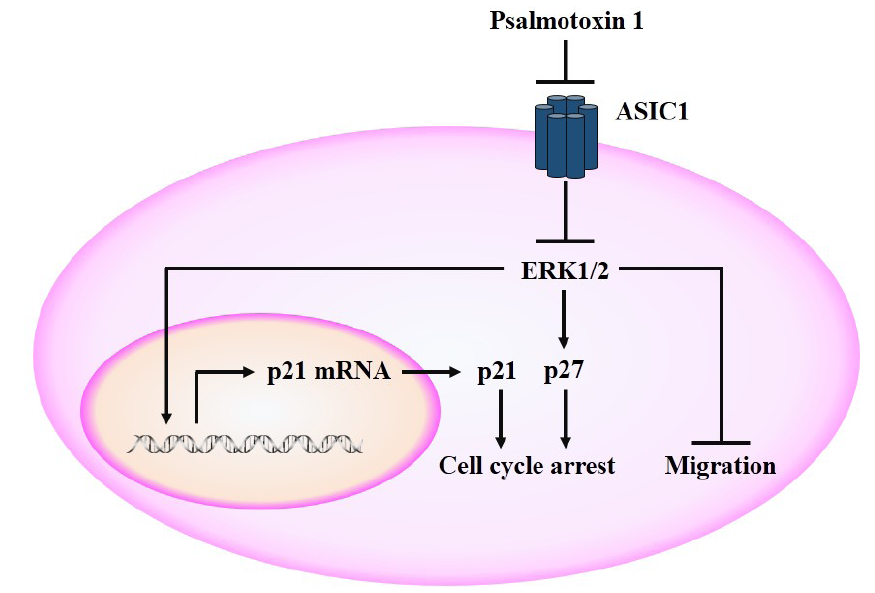
Figure 3. The anti-tumor mechanism of PcTx1. PcTx1 can suppress activation of ERK1/2 by inhibiting ASIC1 channels, followed by upregulating p21 and p27 protein expression to arrest the cell cycle. The level of p21 mRNA increases, but that of p27 mRNA does not change. The inhibition of ERK1/2 phosphorylation also restricts migration, but the mechanism remains unclear. ASIC1: Acid-sensitive ion channel 1; PcTx1: Psalmotoxin1